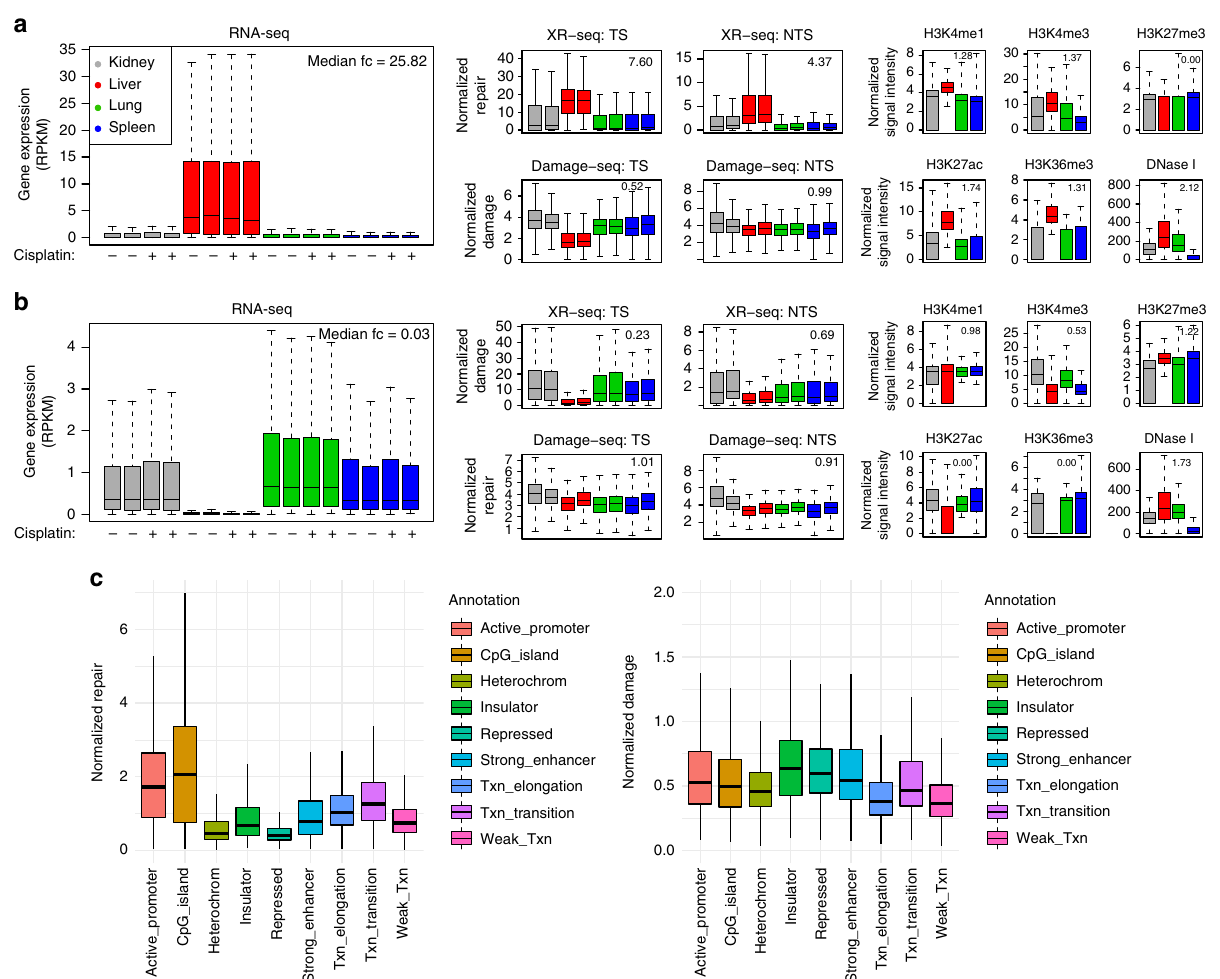
Fig. 4 Association of DNA damage and repair with gene expression and chromatin states. a A total of 602 genes that are highly expressed in liver show higher transcription-coupled repair (in TS) and global repair (in NTS). Expression levels for these genes are also correlated with ChIP-seq signals for histone modi fi cation markers (H3K4me1, H3K4me3, H3K27ac, and H3K36me3). b A total of 414 genes that are lowly expressed in liver have lower repair and are characterized by H3K27me3, a marker for gene inactivation. Chromatin accessibility (DNase I hypersensitivity site) is higher for both groups of genes in a and b , indicating a role of chromatin states in transcriptional regulation. Median fold change (fc) between liver and the other organs across all signi fi cant genes is included on the upper right corner within each panel. c Whole-genome analysis results of DNA damage and repair in liver, with different genomic annotations. Analysis of repair (left) and damage (right) levels across nine genomic annotations for mouse liver reveals uniform distribution of damage but higher repair in active promotor, CpG island (enriched at transcription start sites), transcription elongation and transition regions